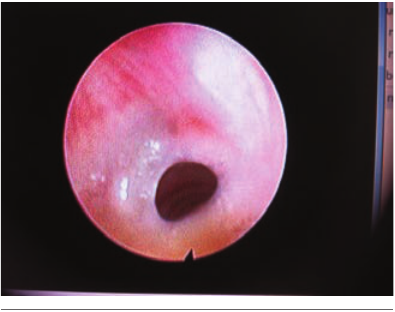
Figure 1. The bronchoscopy shows severe subglottic stenosis; below the trachea the respiratory tree was found to be